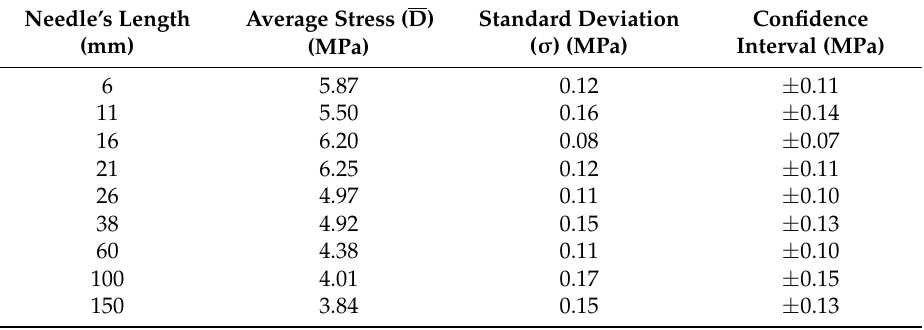
Table 4. The relationship between needle length and the maximal puncture stress of nanofiber membrane.